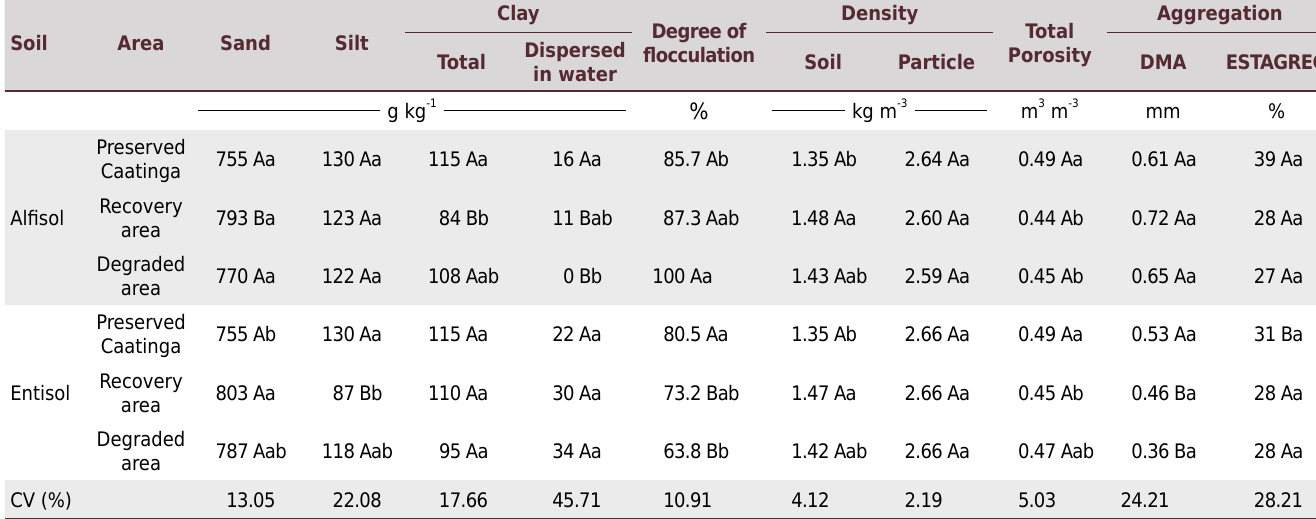
Table 3. Analysis of total and dispersed clay in water, flocculation degree, soil and particle density, total porosity, and soil aggregation of the superficial layers of a Alfisol and a Entisol evaluated from the preserved Caatinga (strata: catingueira, jurema, marmeleiro, and between trees), the recovery area with jurema (strata: jurema, and between trees), and the degraded area without plant cover, at the layer of 0.00-0.10 m, in the dry